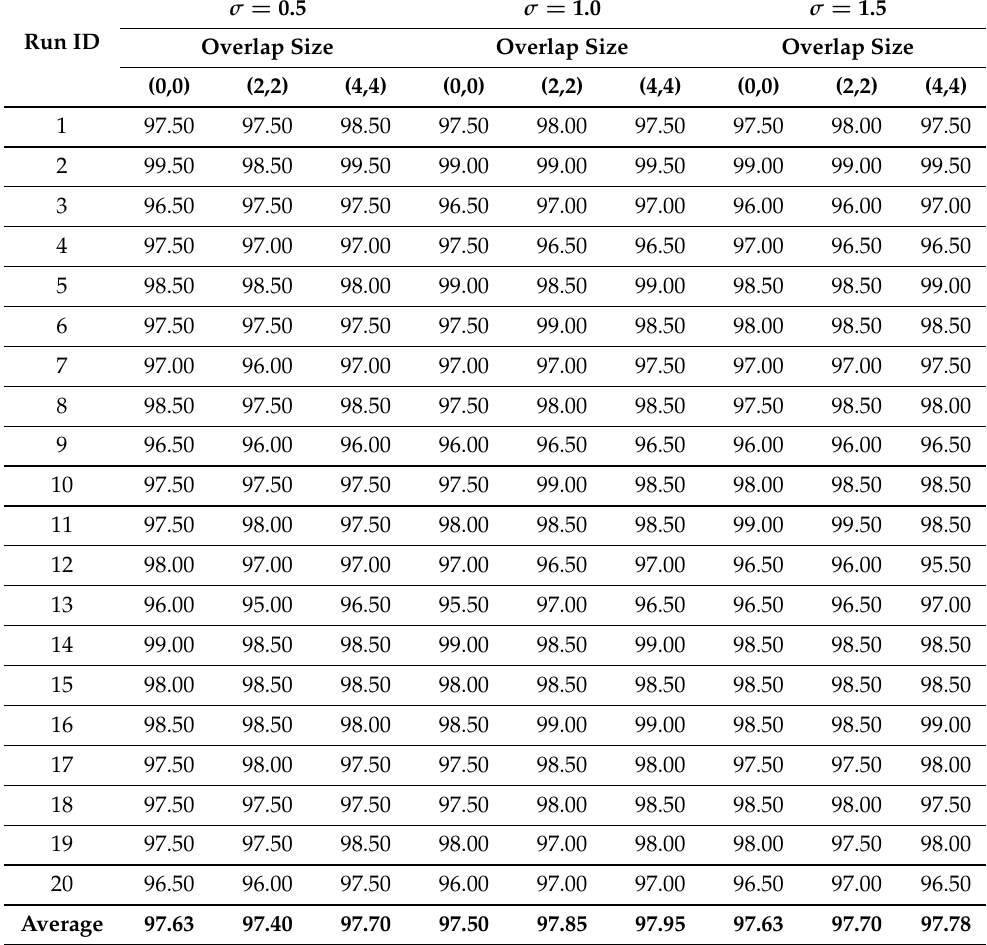
Table A4. The results of the runs for Salt and Pepper noise with density of 0.05 using different values of σ